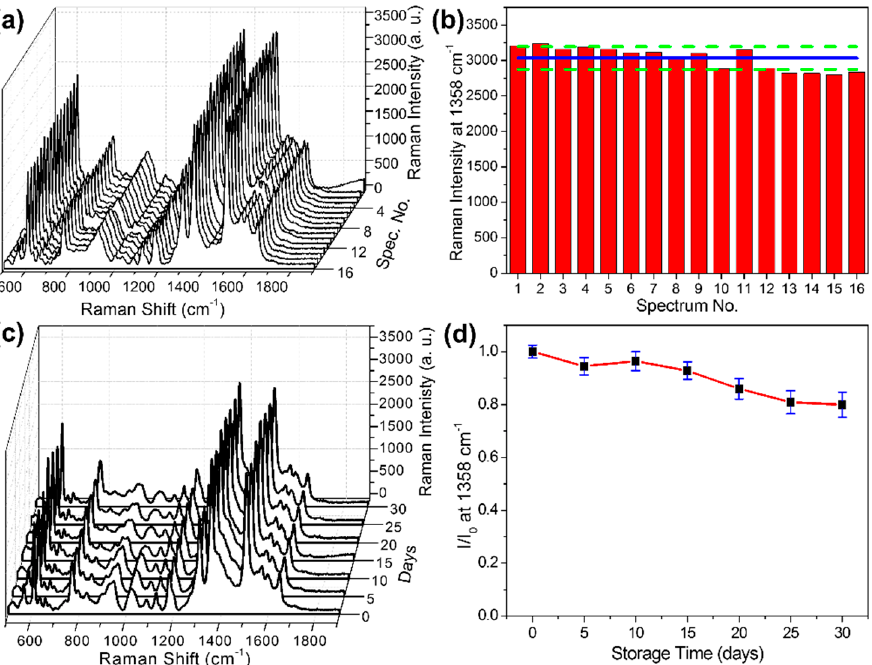
Figure 3. SERS spectra ( a ) and distribution of signal intensity ( b ) at 1358 cm − 1 of R6G (100 µ g L − 1 ) collected from 16 random points on optimized AgNPs − PDMS substrate. The solid line in b represents the average SERS intensity, and the dotted lines indicate the RSD. SERS spectra ( c ) and the ratio of intensities ( d ) at 1358 cm − 1 of R6G (100 µ g L − 1 ) acquired on optimized AgNPs-PDMS sub-strate stored in nitrogen atmosphere between 0 and 30 days.